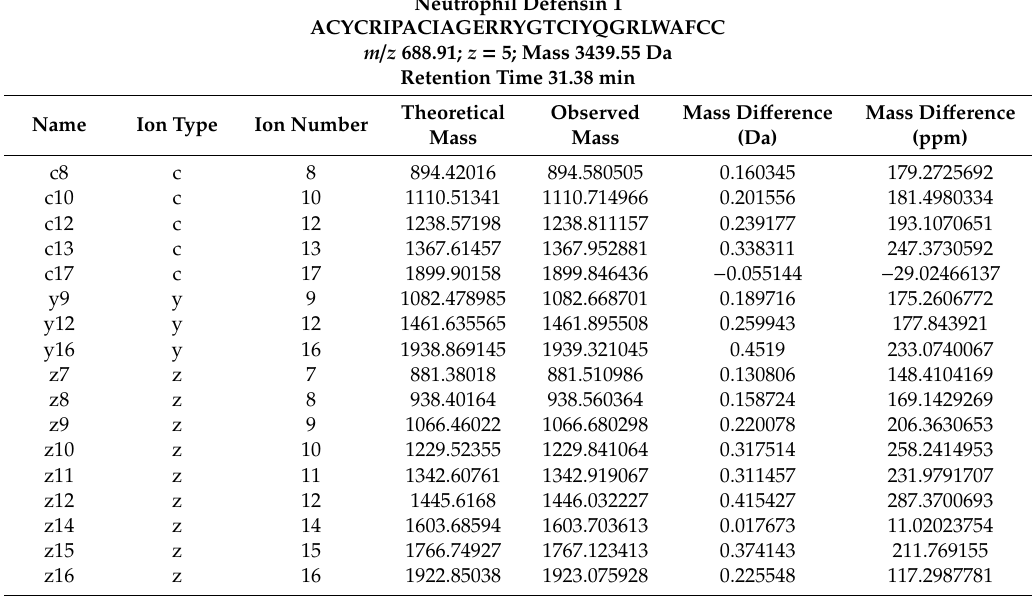
Table 1. List of annotated fragment ions in the deconvoluted fragmentation spectrum. The mixture of c, y and z fragment ions were aligned to the amino acid sequence of neutrophil defensin 1, generated with Prosight lite with 300 ppm mass